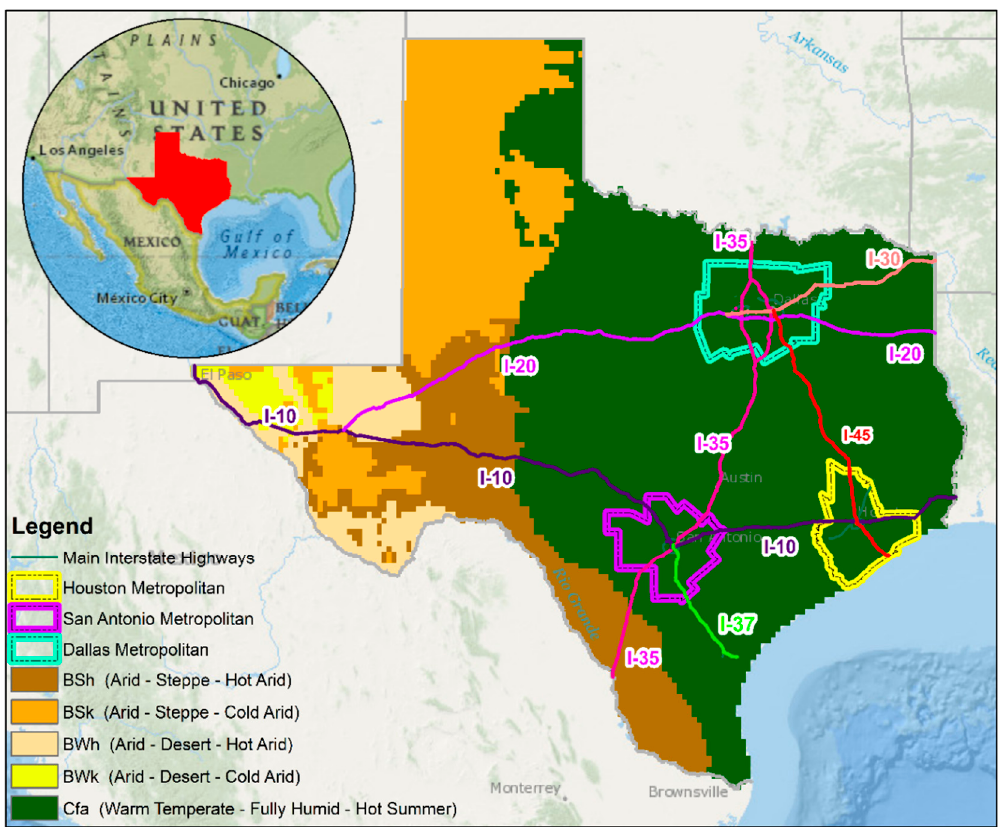
Figure 1. Texas climate according to the Koppen–Geigre Climate Classification.